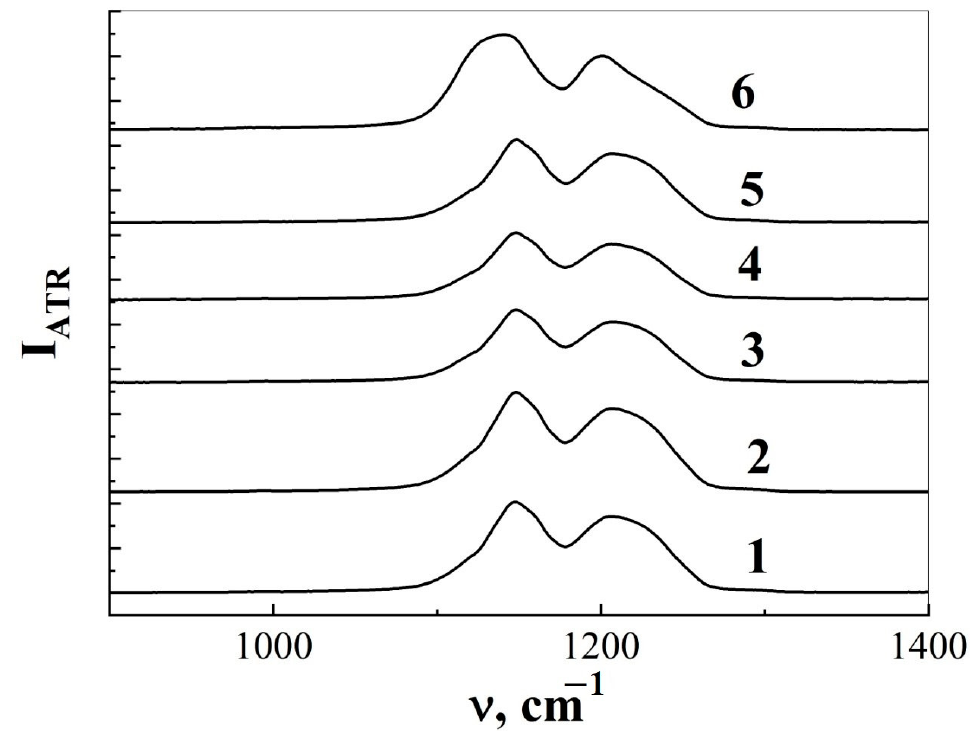
Figure 1. Change in the spectral shape of vibrational modes corresponding to antisymmetric and symmetric valence vibrations of the C-F bond in the infrared spectra of the disturbed total internal reflection of thermoradiationally modified polytetrafluoroethylene irradiated with xenon ion fluxes with an energy of ~1 MeV/nucleon to fluences 0 (1), 10 8 (2), 10 9 (3), 10 10 (4), 3 × 10 10 (5) and 10 11 cm − 1 (6).